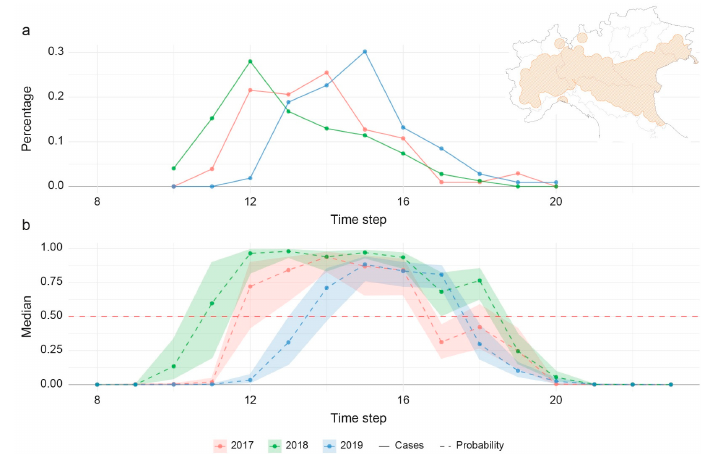
Figure 9. Northern Italy ( a ): percentage of observed veterinary cases in each time step in 2017 (red), 2018 (green), 2019 (blue); ( b ): median value (and 0.25 confidence interval) of the estimated probability of being infected at each time